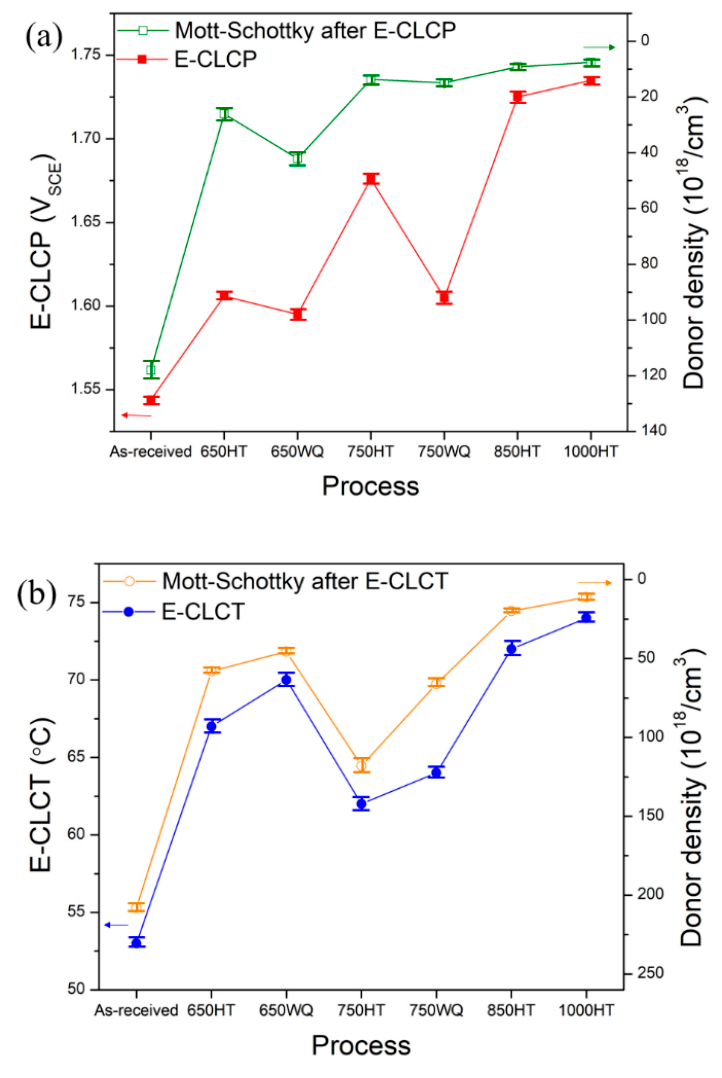
Figure 15. Comparison between ( a ) donor densities and E-CLCP and ( b ) donor densities and E-CLCT for the as-received and heat-treated AM Ti–6Al–4V alloys using furnace cooling or water quenching methods (HT: furnace cooling; WQ: water